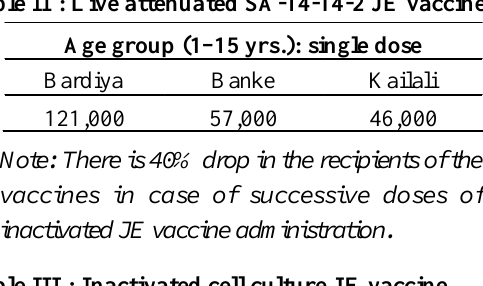
Table III : Inactivated cell culture JE vaccine